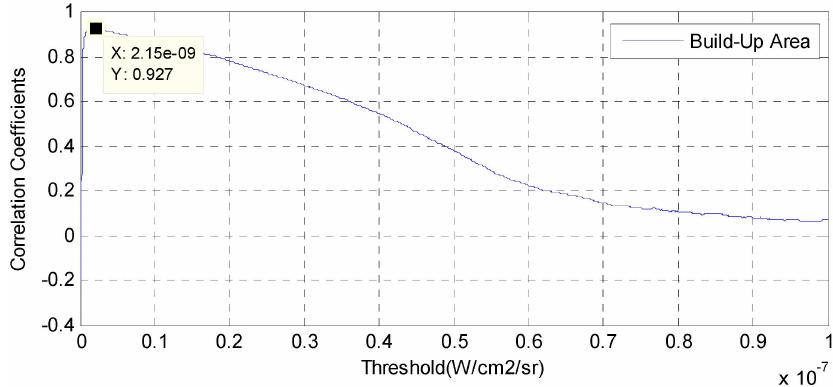
Figure 3. Correlation coefficient between built-up area and light area vs. different threshold values (see Equation (4)) for 31